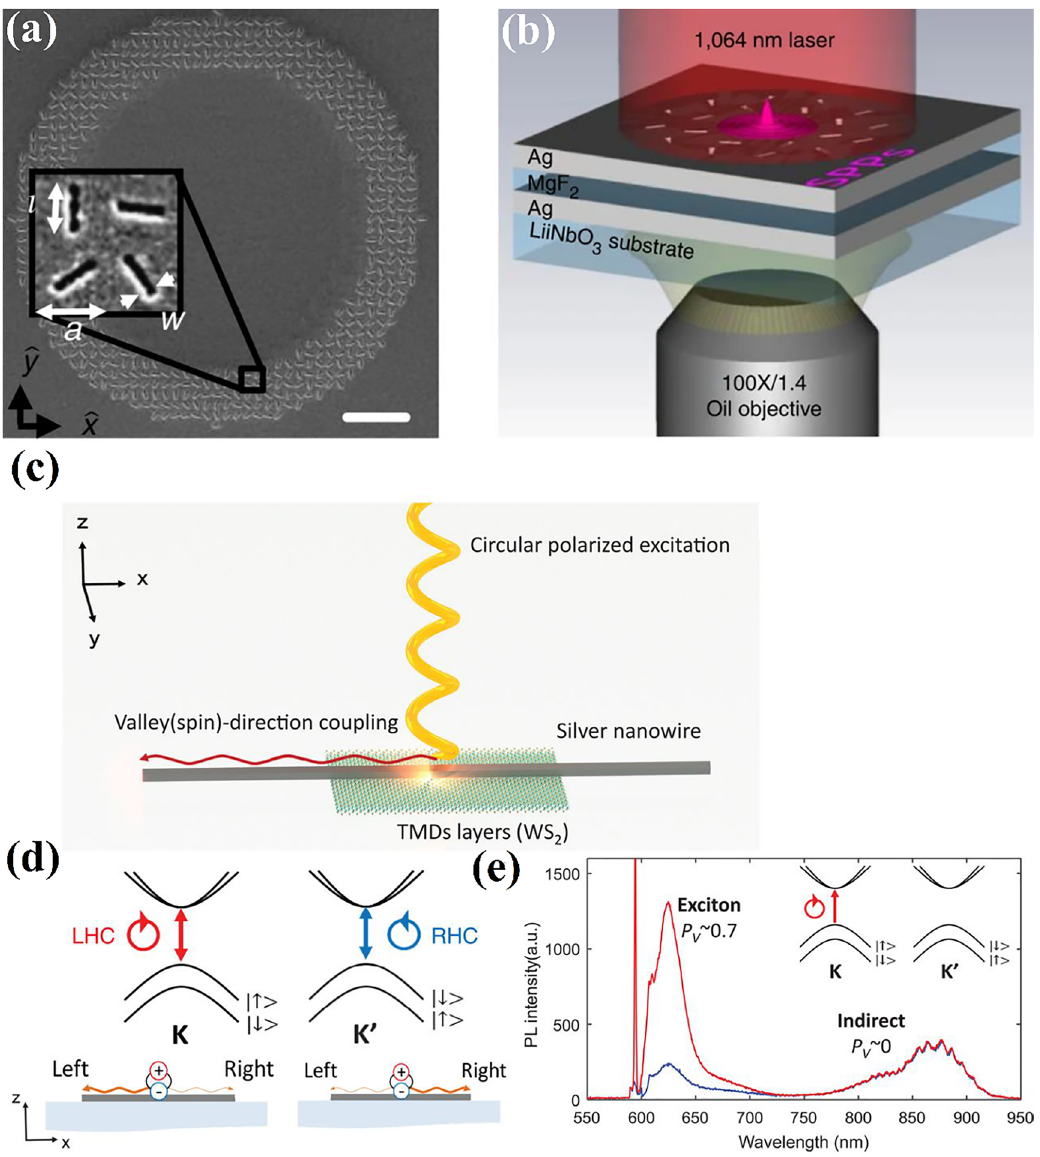
Figure 9: PSHE in hybrid metal structure: a, experiment sample for spin-driven orbit control. Scale bars, 4 μ m [113]; b, schematics of the experimental set-up [113]; Copyright 2015, Reprinted with permission of Springer Nature Limited. c, schematics of valley-polarized exciton emission in WS 2 [114]; d, the band diagram and optical selection rules of WS 2 [114]; e, polarization emission spectrum of WS 2 without an Ag nanowire